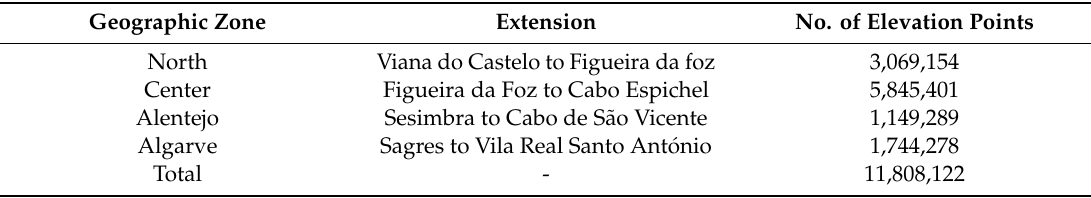
Table 3. Number of elevation points for each geographical